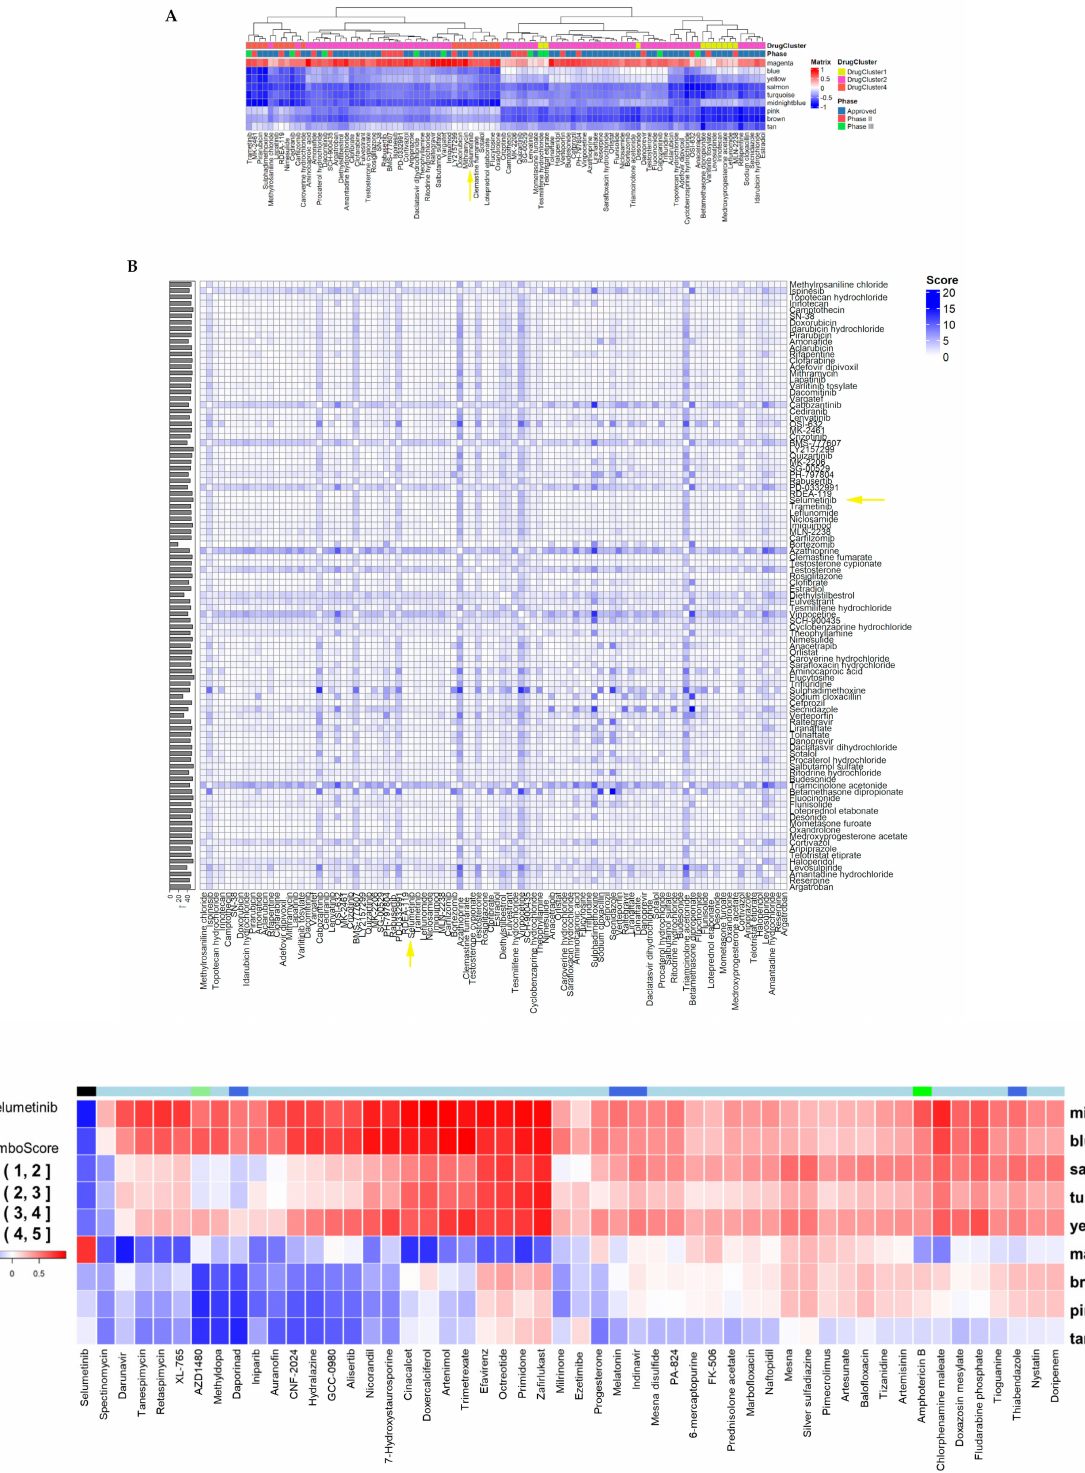
Figure 4. Fingerprint-guided drug selection and combination strategies. ( A ) Selumetinib-like drug candidates with the similar fingerprint pattern. The color bar at the top of the figure indicates the corresponding drug clusters and clinical status of each drug. Selumetinib was indicated by the yellow arrow. ( B ) The heatmap of IDAcomboscore of any two-drug combination among the